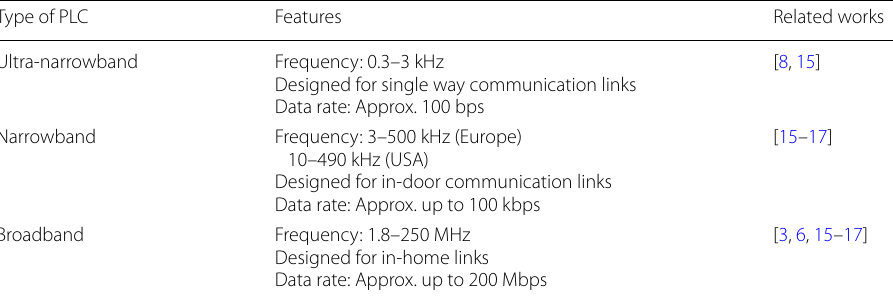
Table 1 Categories of PLC technology Type of